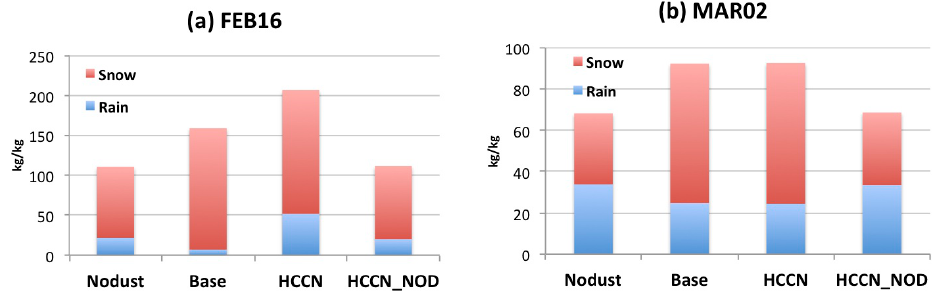
Fig. 8. Total rain (blue) and snow (red) mass concentrations at the lowest model level ( ∼ 50m above terrain height) summed over the domain 2 and during the day (00:00–23:00UTC) from all the simulations shown in x-axis for (a) FEB16 and (b) MAR02.